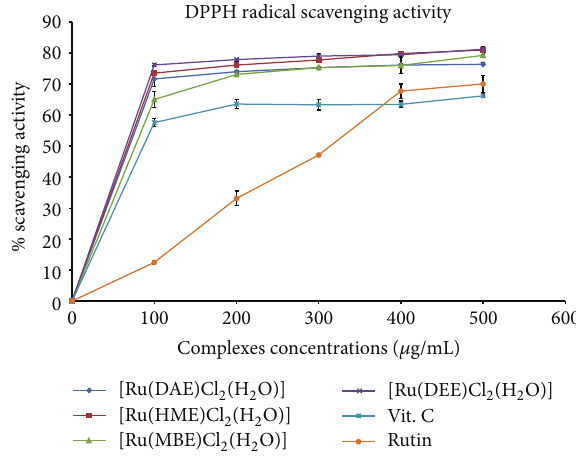
Figure 5: DPPH scavenging potential of Ru(III)-Schiff base com-